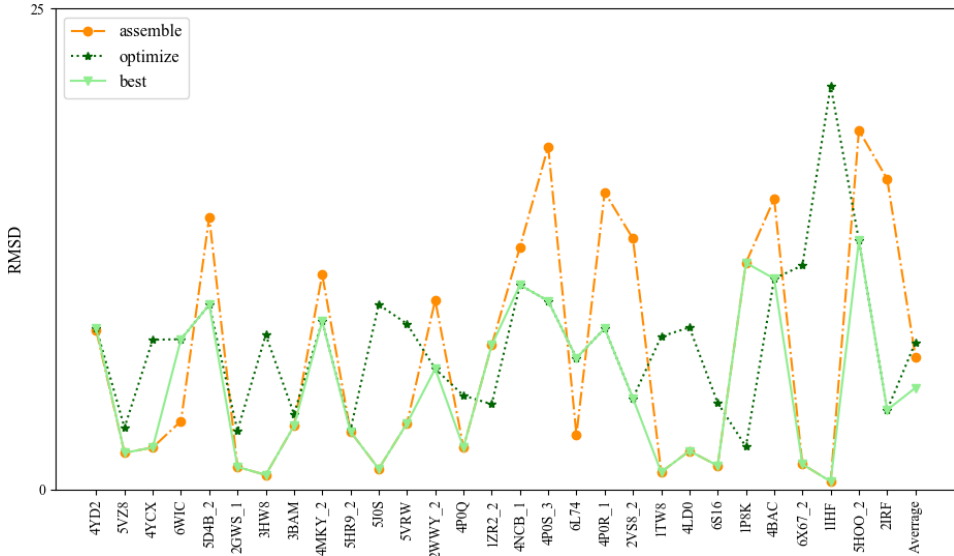
Figure 6. Comparison of the prediction accuracies (all-atom RMSDs) of 3dDNA for assembled, optimized, and best structures of DNAs with multi-chains. Table 3. Information and prediction accuracies (RMSD in Å ) of 29 multi-chain DNAs.